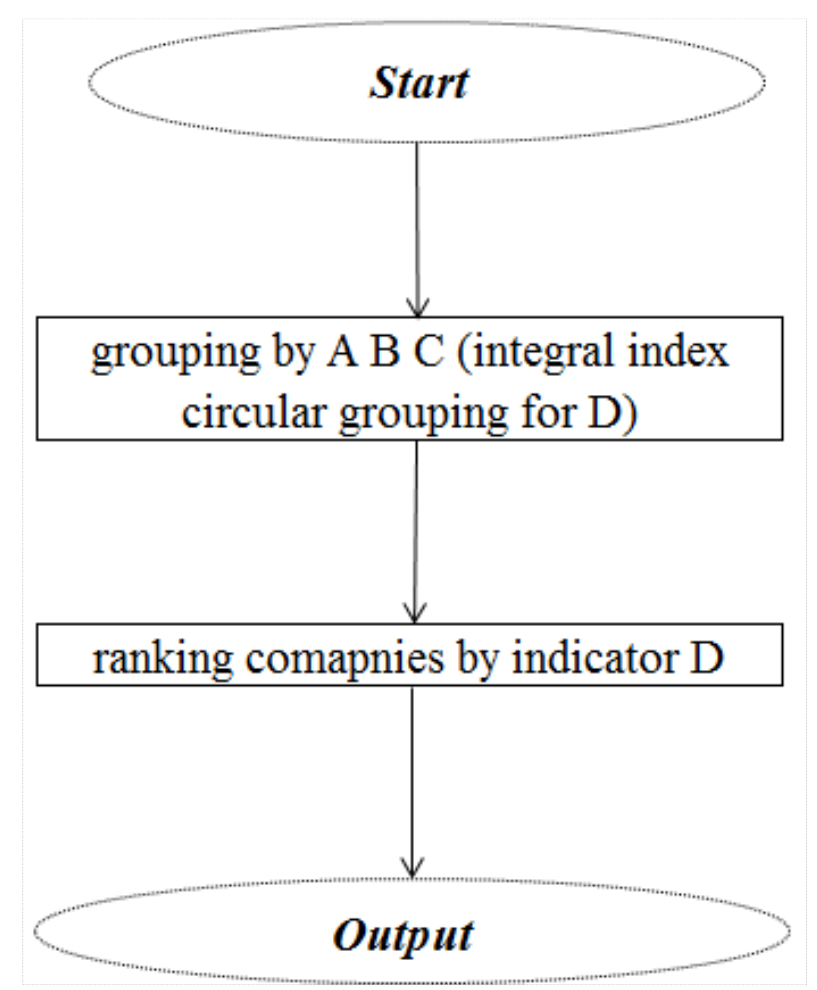
Figure 1. CAD by scheme of information flows, integrated rating. The method of circular convolution of large companies. At the first stage, two groups are identified: the leaders (ABC indicators are above average) and the last (ABC below average). The remaining companies form a middle group, which is subject to further ranking according to the principle: from the borders to the center of the circle after the signal to stop the process is received: the presence of one or two groups of leaders and the closing ones without the possibility of allocating the middle group. At the second stage, an integral rating is built. The indicator D is applied, first for all the leading groups, from 1 to the last, then in the central group according to the results of the hierarchical analysis, and then for the closing groups from the last to the first (boundary) (Figure